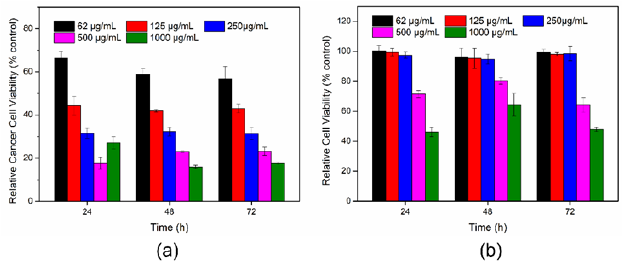
Figure 6. ( a ) Relative cancer cell viability with DOX-loaded PCL 16 - b -K 20 vesicles; ( b ) relative normal cell viability with DOX-loaded PCL 16 - b -K 20 vesicle ( n = 6).